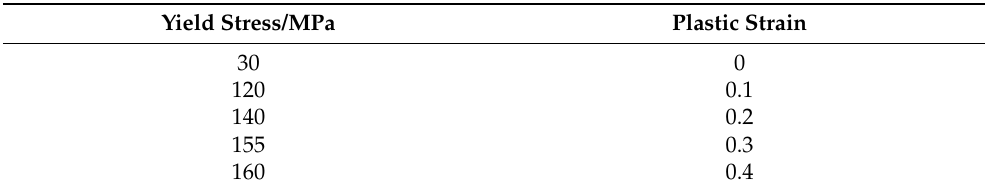
Table 3. Material plastic characteristics of